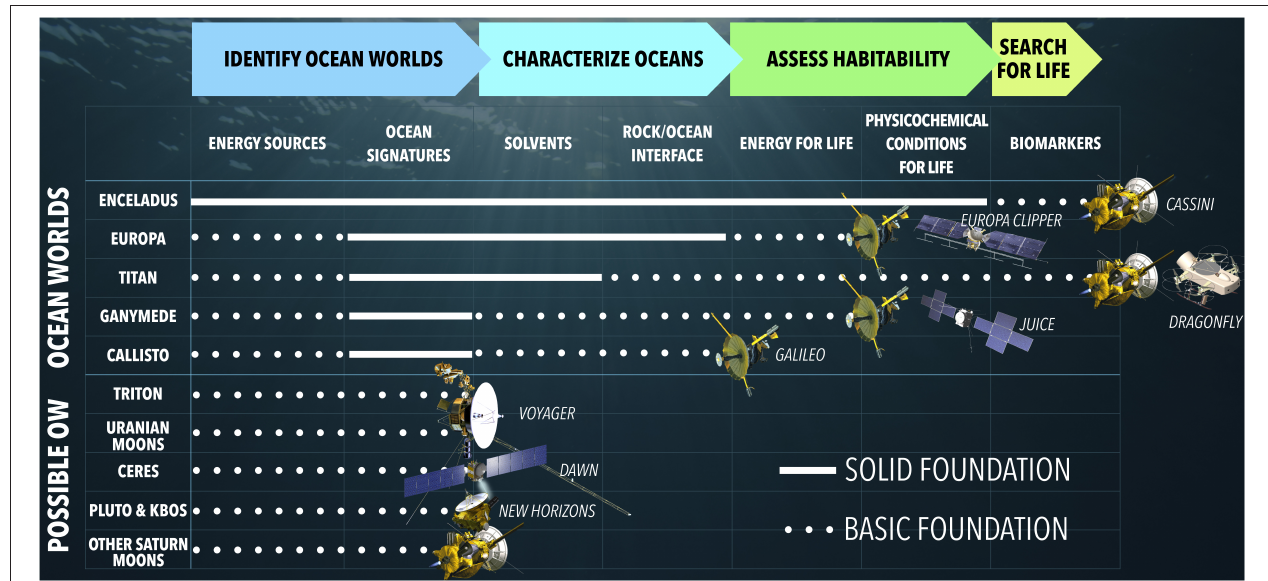
FIGURE 1 | Enceladus is farthest along the roadmap to understanding the potential of ocean worlds to harbor life (Hendrix et al., 2019). White lines across roadmap milestones depict the current state of knowledge for each world or class of worlds from past exploration by the Cassini, Galileo, Voyager, Dawn, and New Horizons spacecrafts (from top to bottom). Upcoming missions such as Europa Clipper (NASA) to Europa, JUICE (ESA) to Ganymede, and Dragonfly (NASA) to Titan will make further progress along this roadmap. Modified from Hendrix et al. (2019) under the terms of a CC BY 4.0 license.